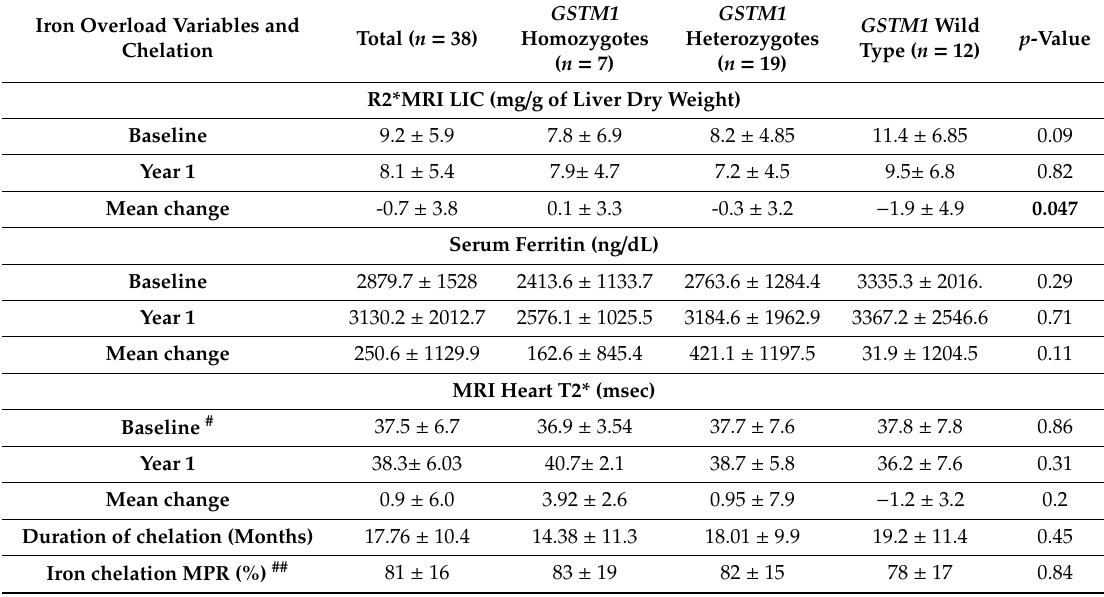
Table 2. Iron burden status stratified by GSTM1 genotype information. Iron Overload Variables and Chelation